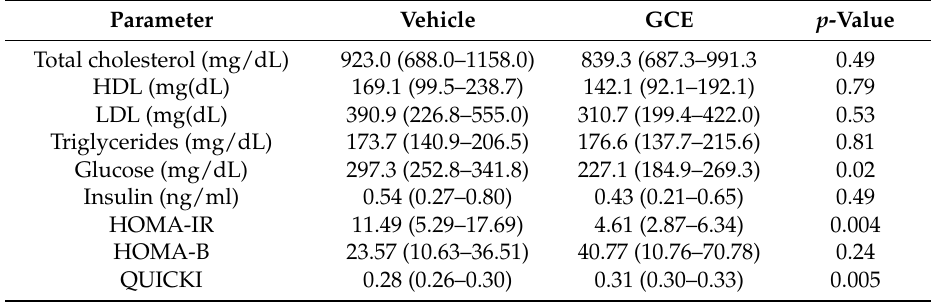
Data are presented as the mean ± 95%